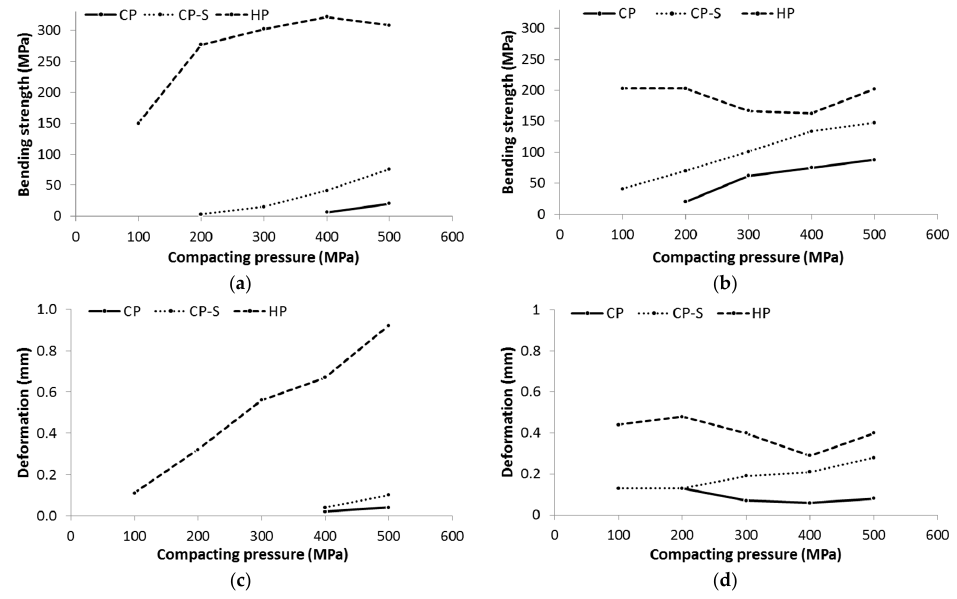
Figure 4. Dependence of flexural strength and displacement on compacting pressure and processing of prepared materials: ( a ) Flexural strength, Zn7.5 powder; ( b ) Flexural strength, Zn150 powder; ( c ) Displacement, Zn7.5 powder; ( d ) Displacement, Zn150 powder.